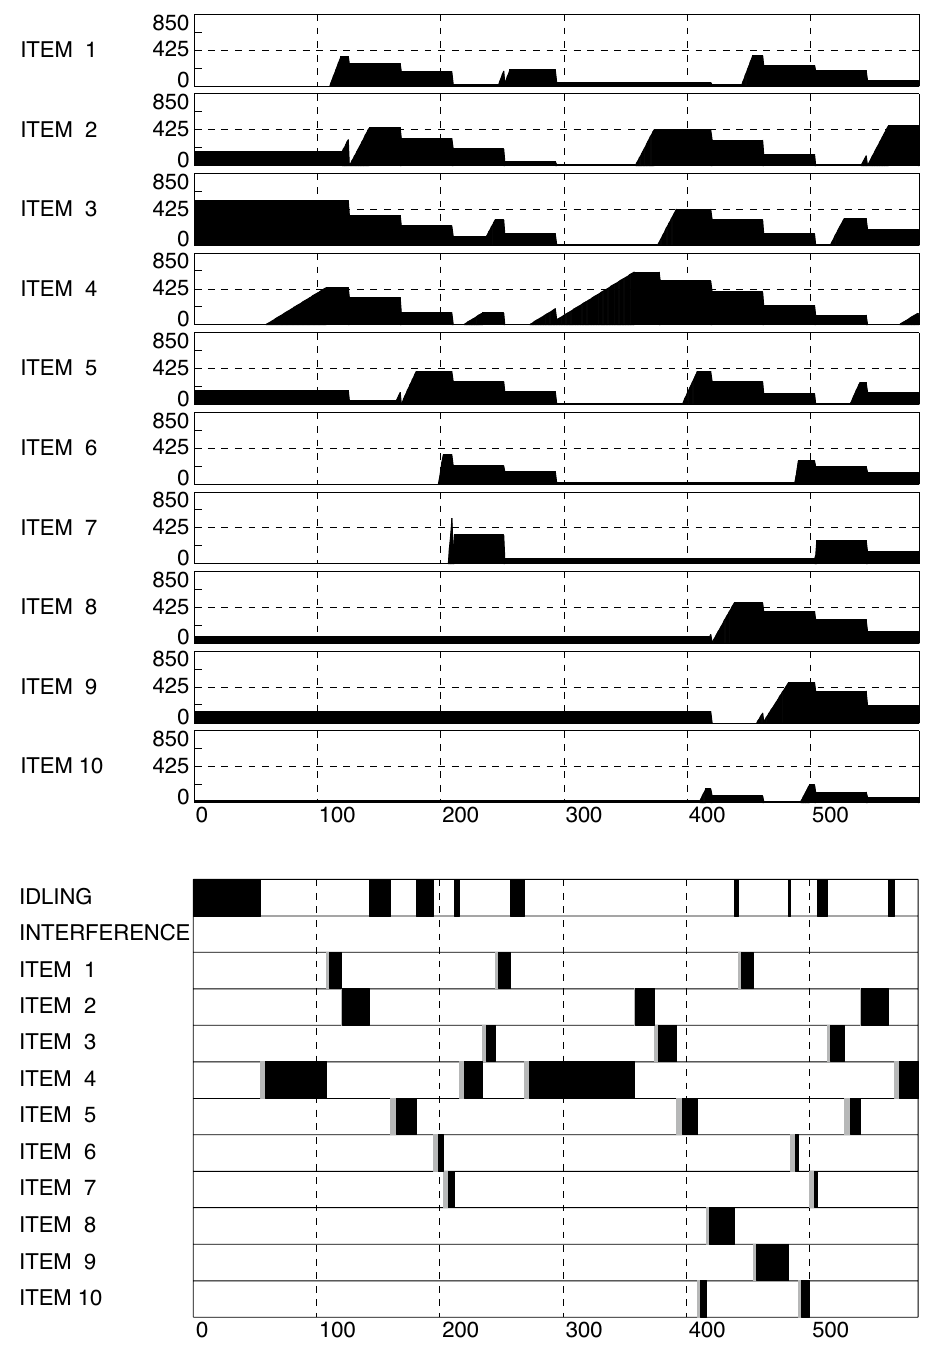
Fig. 3 Solved feasible